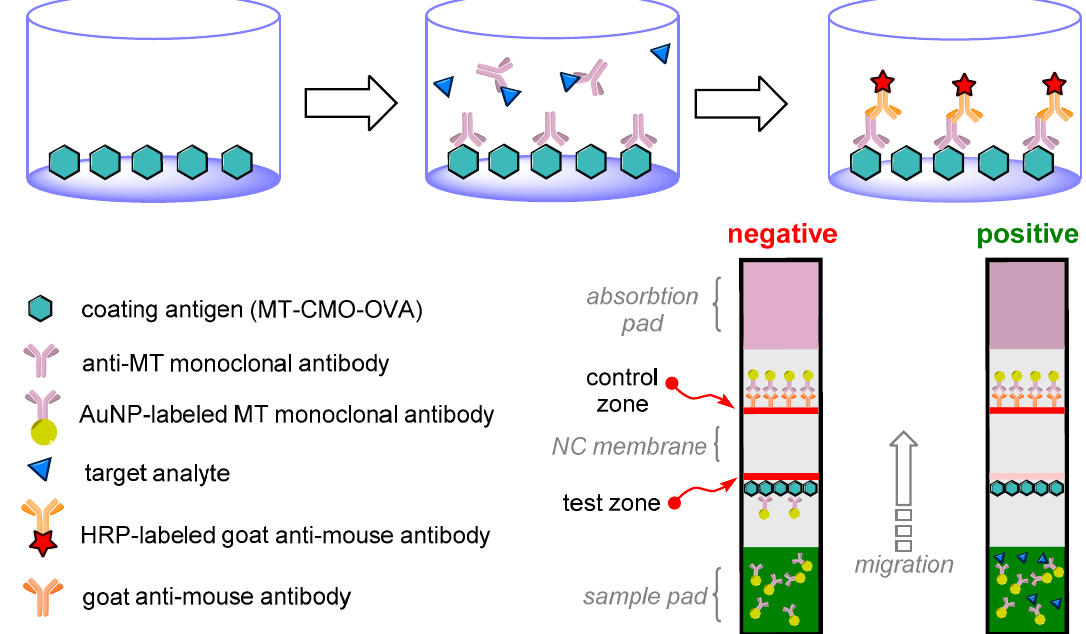
Table 3. Lateral flow immunoassays (LFIAs) for the determination of anabolic-androgenic ster- oids.